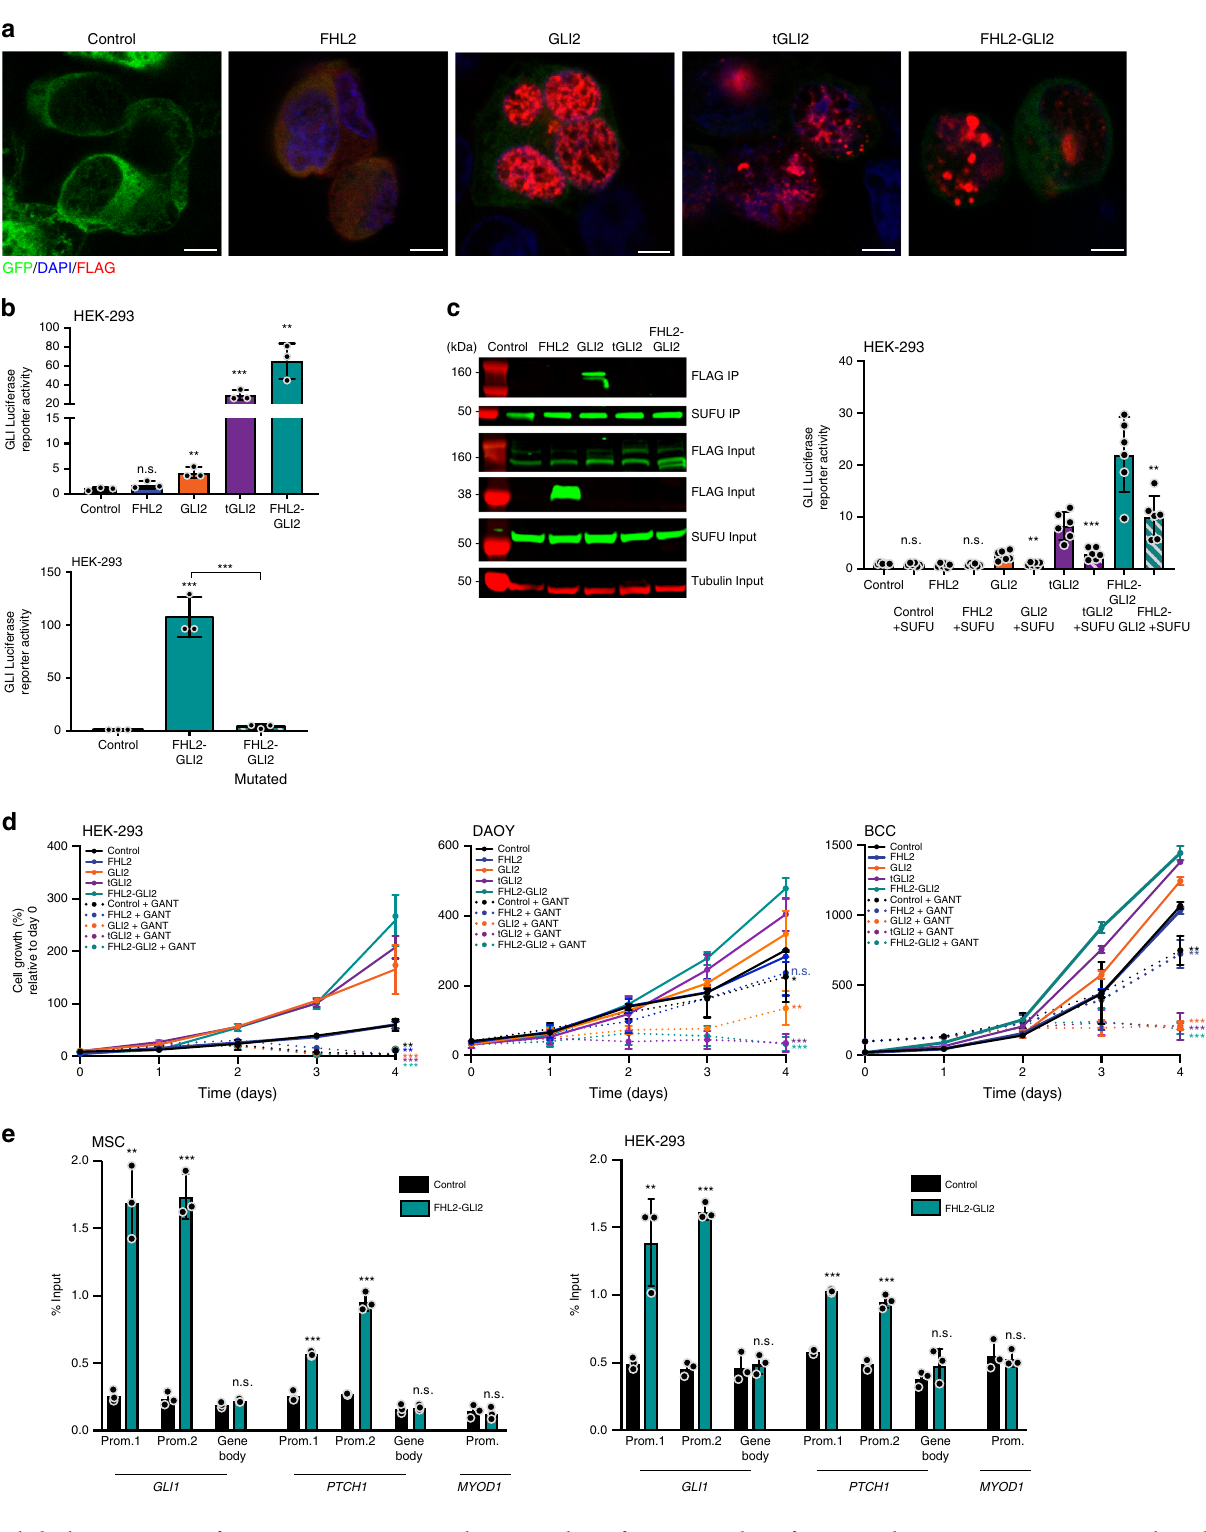
revealed the presence of GLI2 rearrangements, however the frozen samples of SSTs with GLI2 rearrangements other than partner genes could not be identi fi ed. Of note, GLI2 protein those described in this study or lacking GLI2 rearrangements expression and SHH pathway activation were also observed in altogether are warranted to de fi ne their driver alterations. Finally, SSTs lacking any of the GLI2 rearrangements identi fi ed here due to the lack of representative cell line models derived from (Fig. 4, Supplementary Figs. 2 and 6), providing evidence to human SSTs, we established cell models using MSC, HEK-293, suggest that mechanisms other than the FHL2-GLI2 and DAOY, and BCC cells with stable expression of the FHL2-GLI2 DYNLL1-GLI2 fusion genes may lead to the constitutive activa- fusion and tGLI2. Despite HEK-293 cells not being representative tion of GLI2 in these lesions. Further studies, ideally utilizing of the likely cell of origin, FHL2-GLI2 expression resulted in the NATURE COMMUNICATIONS| (2020) 11:44